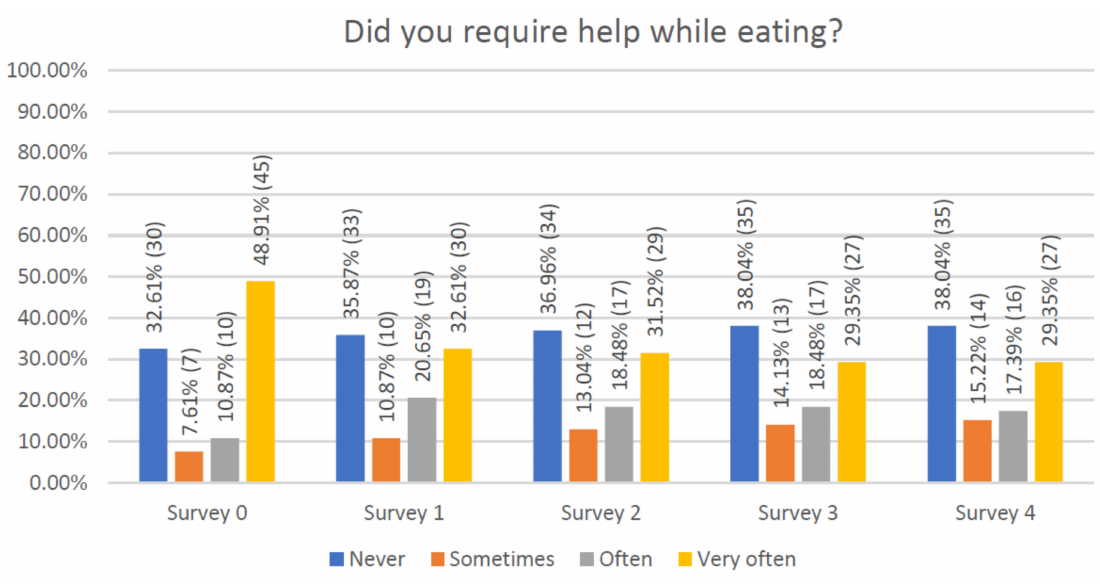
Figure 6. Declaration of respondents regarding independence while eating meals. Evaluating the overall improvement in physical fitness, week after week, patients expressed an initial negative impression in 97.8% of cases, to reach a value of less than 40% by the end of the study (Figure 7). The statistical analysis of the data showed a progressive significant increase in the weekly physical fitness. The differences were not significant in the comparisons between the last two weeks (Table